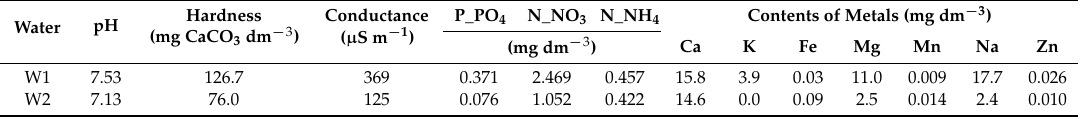
Table 1. Selected quality indexes of the environmental